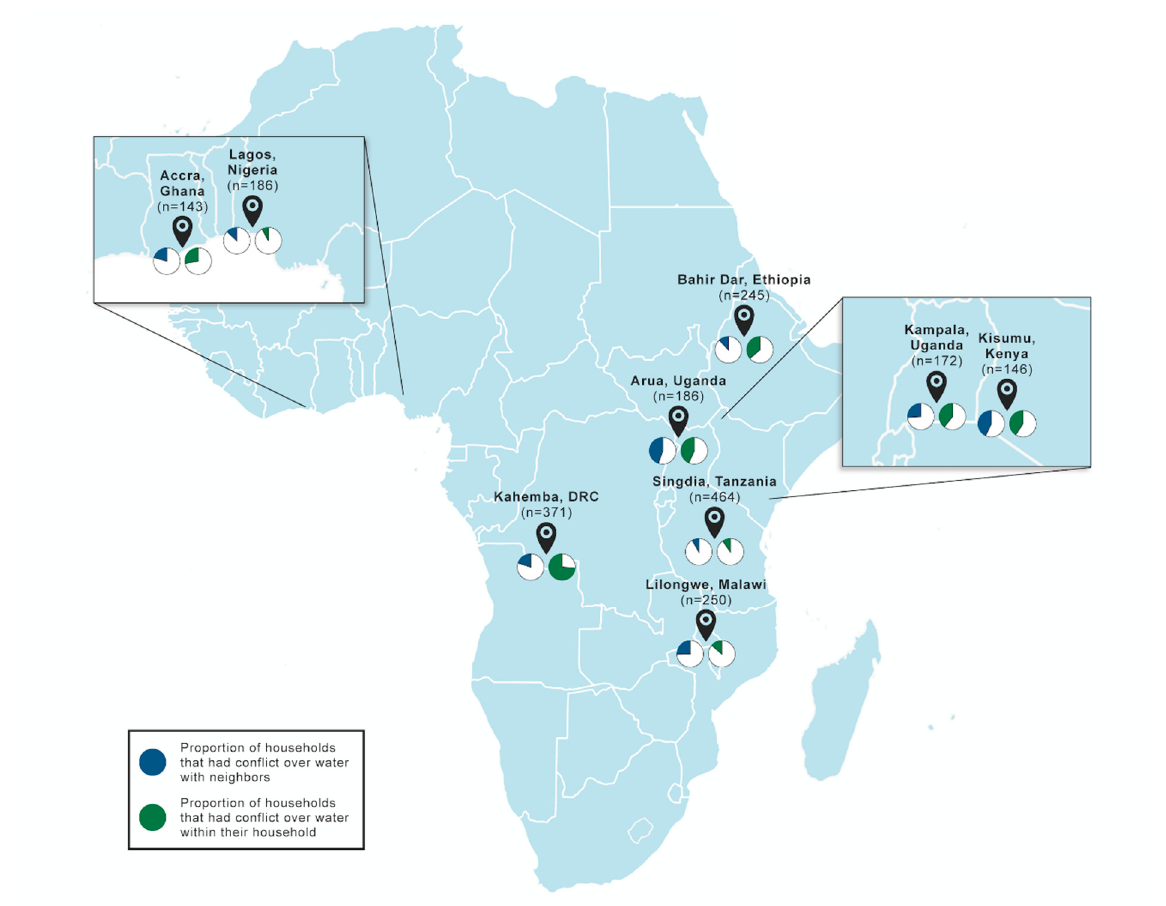
Figure 1. Map of study sites and proportions of households reporting conflict over water within the household or with neighbors.